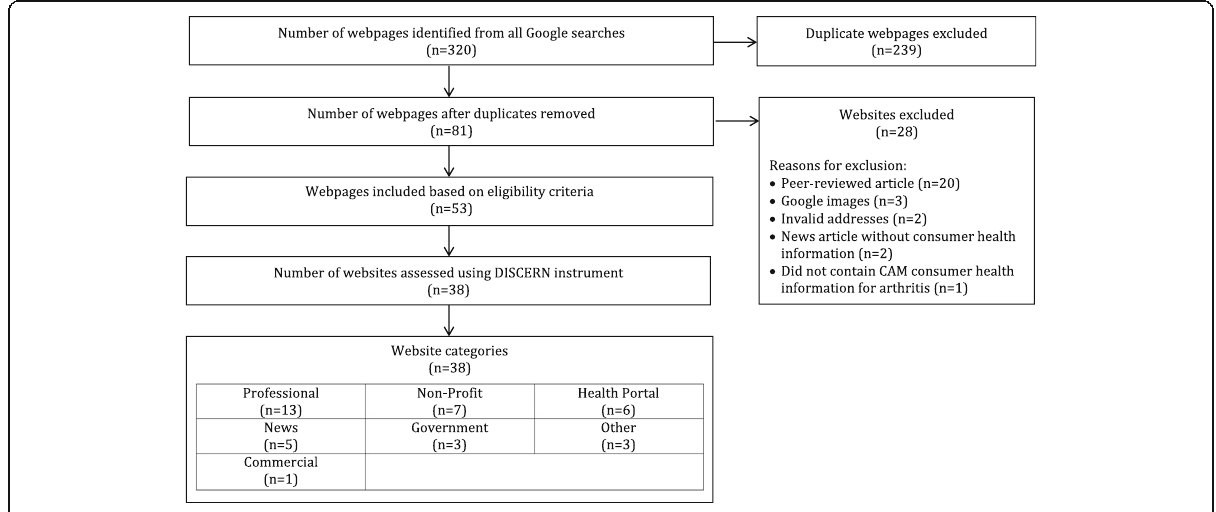
Fig. 1 Web Information Search Strategy and Assessment